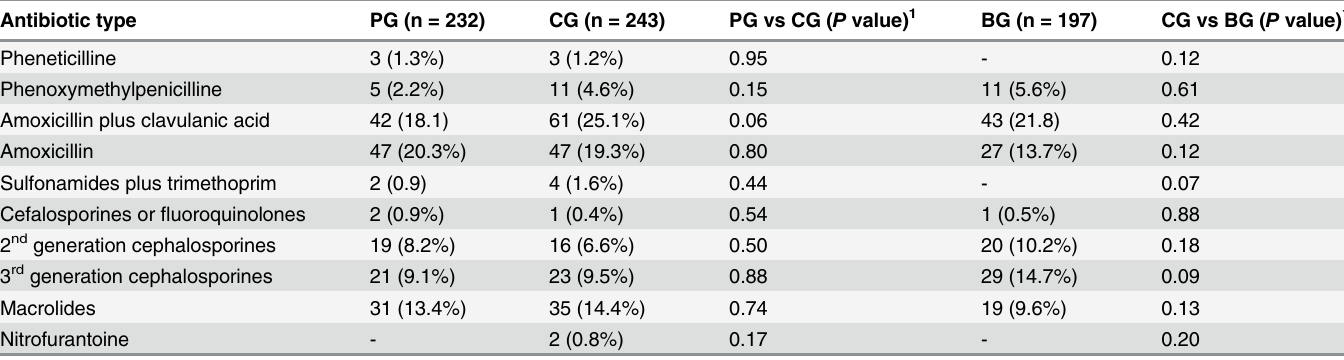
Table 6. Use of antibiotics from third to fifth birthday. Antibiotic type